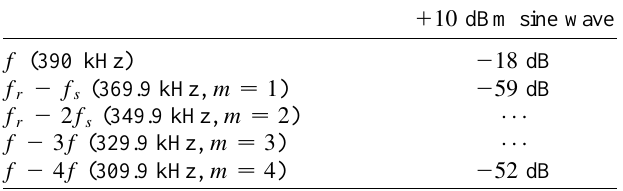
TABLE VIII. The beam spectra amplitudes from the spectrum analyzer when modulating the amplitude of the rf voltage at 309.9